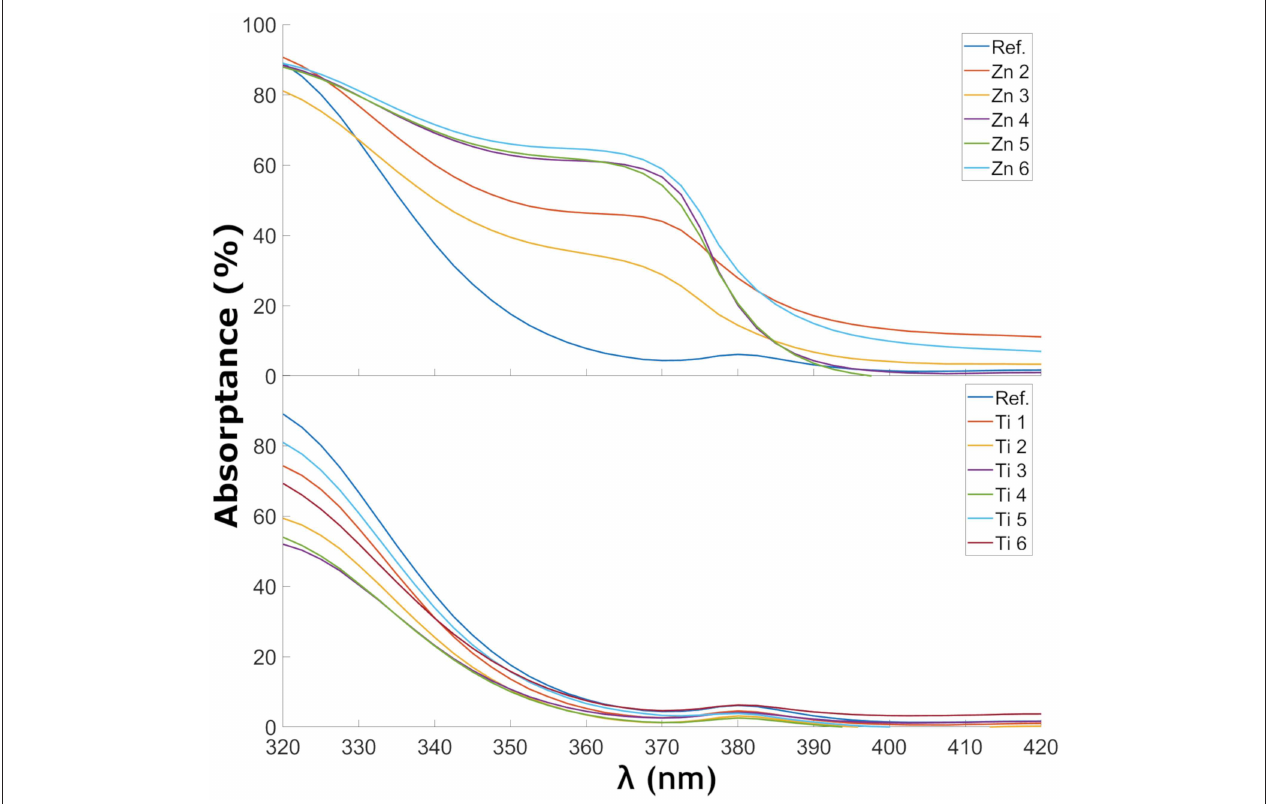
FIGURE 6 | Absorptance of ZnO- and TiO 2 -coated glass samples in the wavelength range near the UV cutoff.